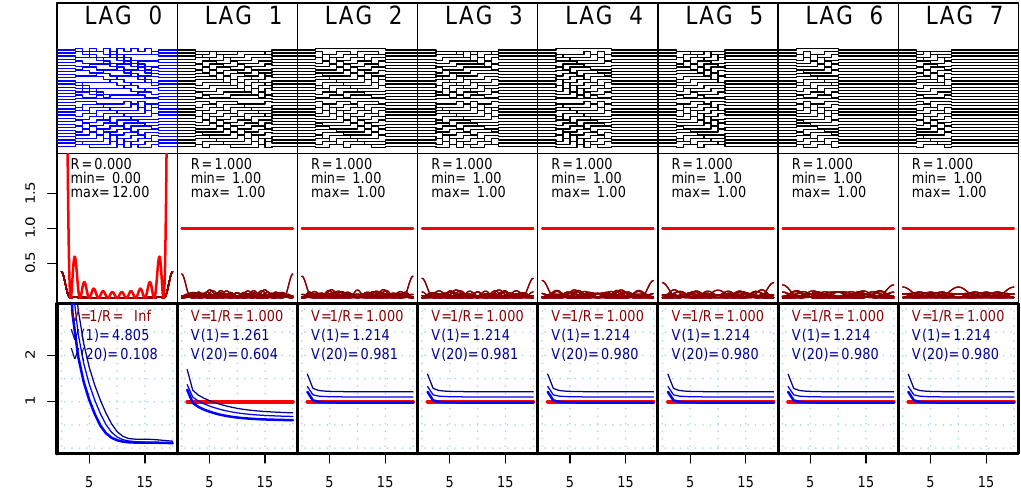
Fig. 5. An alternating code set made from a 16-bit strong alternating code by truncating to 12 bits. We have only shown the most natural fractional lag set: ± 2/5, ± 1/5 and 0. It is clear that all lags ≥ 2 display a perfect decoding behaviour – they behave as if plain 2-pulse pairs corresponding to all 2-pulse-pairs in the set would have been